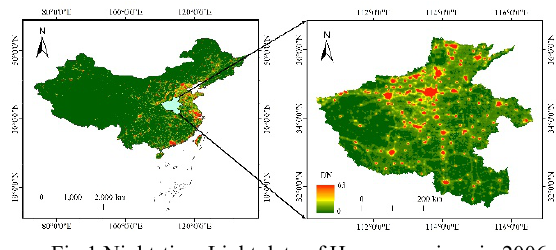
Fig.1 Night-time Light data of Henan province in